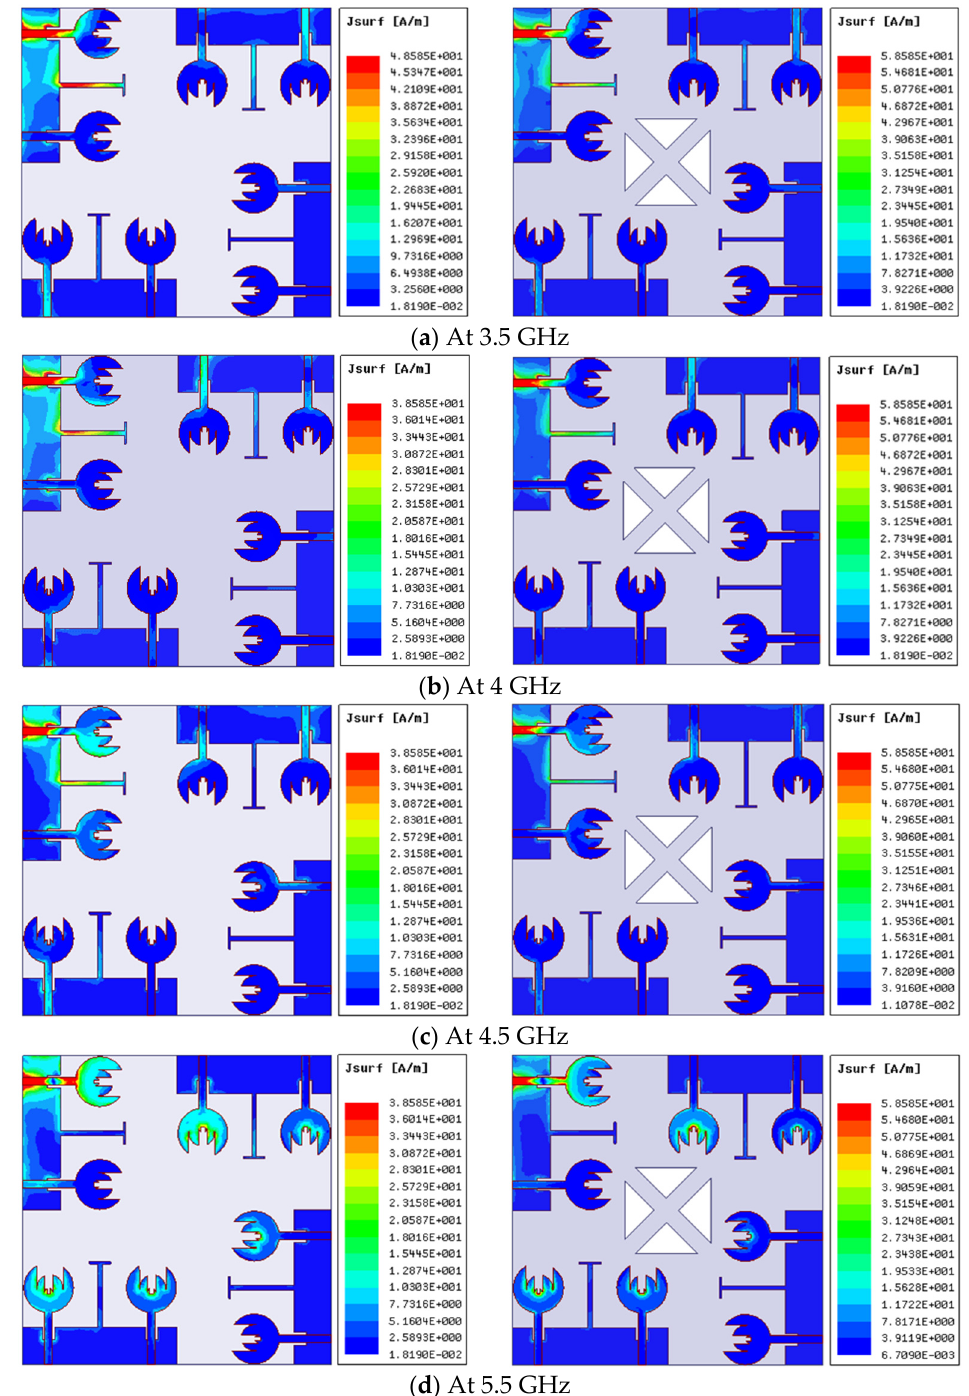
Figure 9. ( a – d ) Eight–element MIMO antenna surface current distribution (SCD) in working band frequencies.